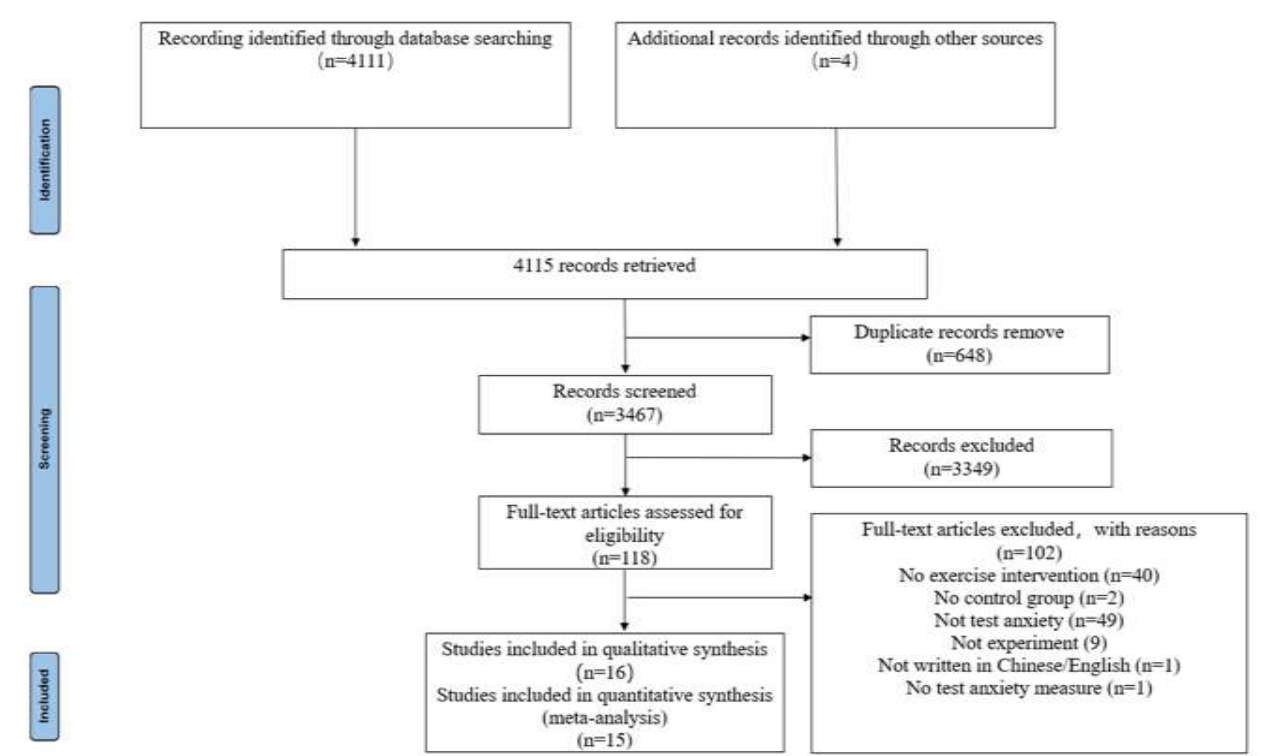
Figure 1. Study selection process.